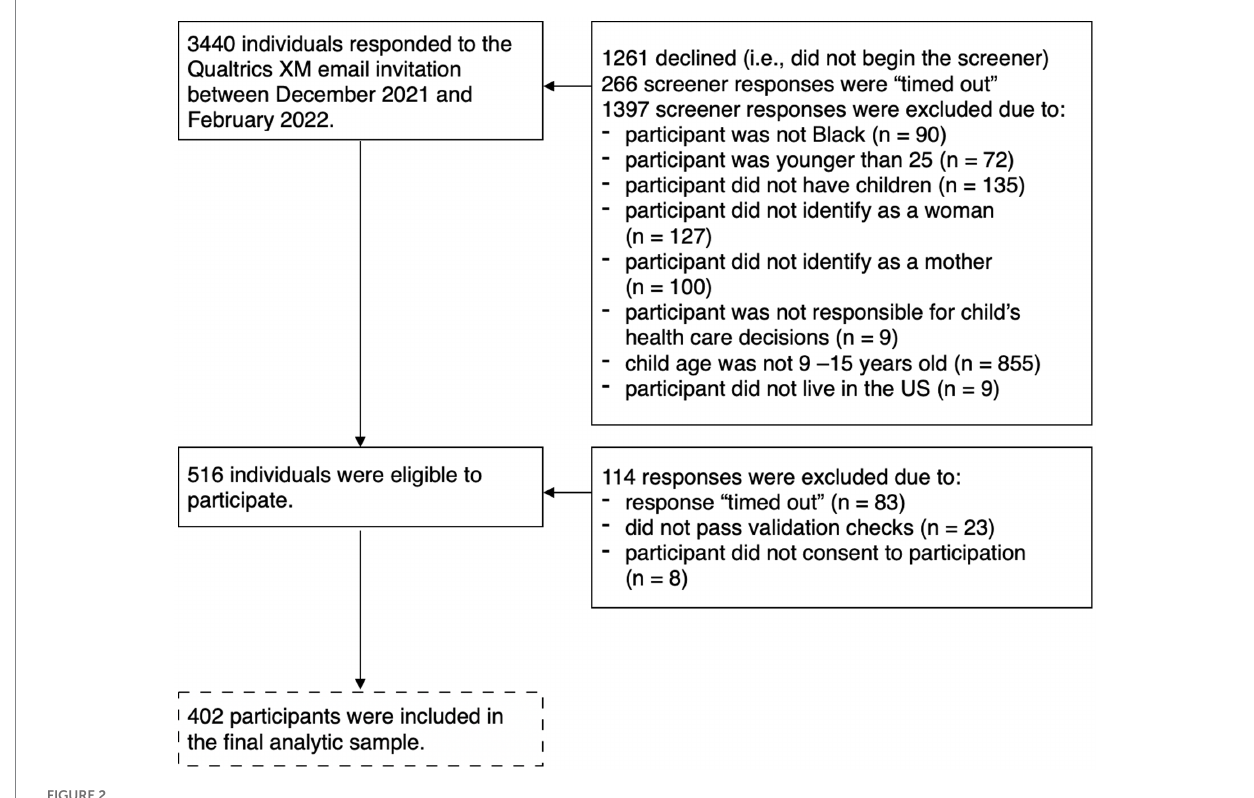
FIGURE 2 Flow chart of participation selection for the current